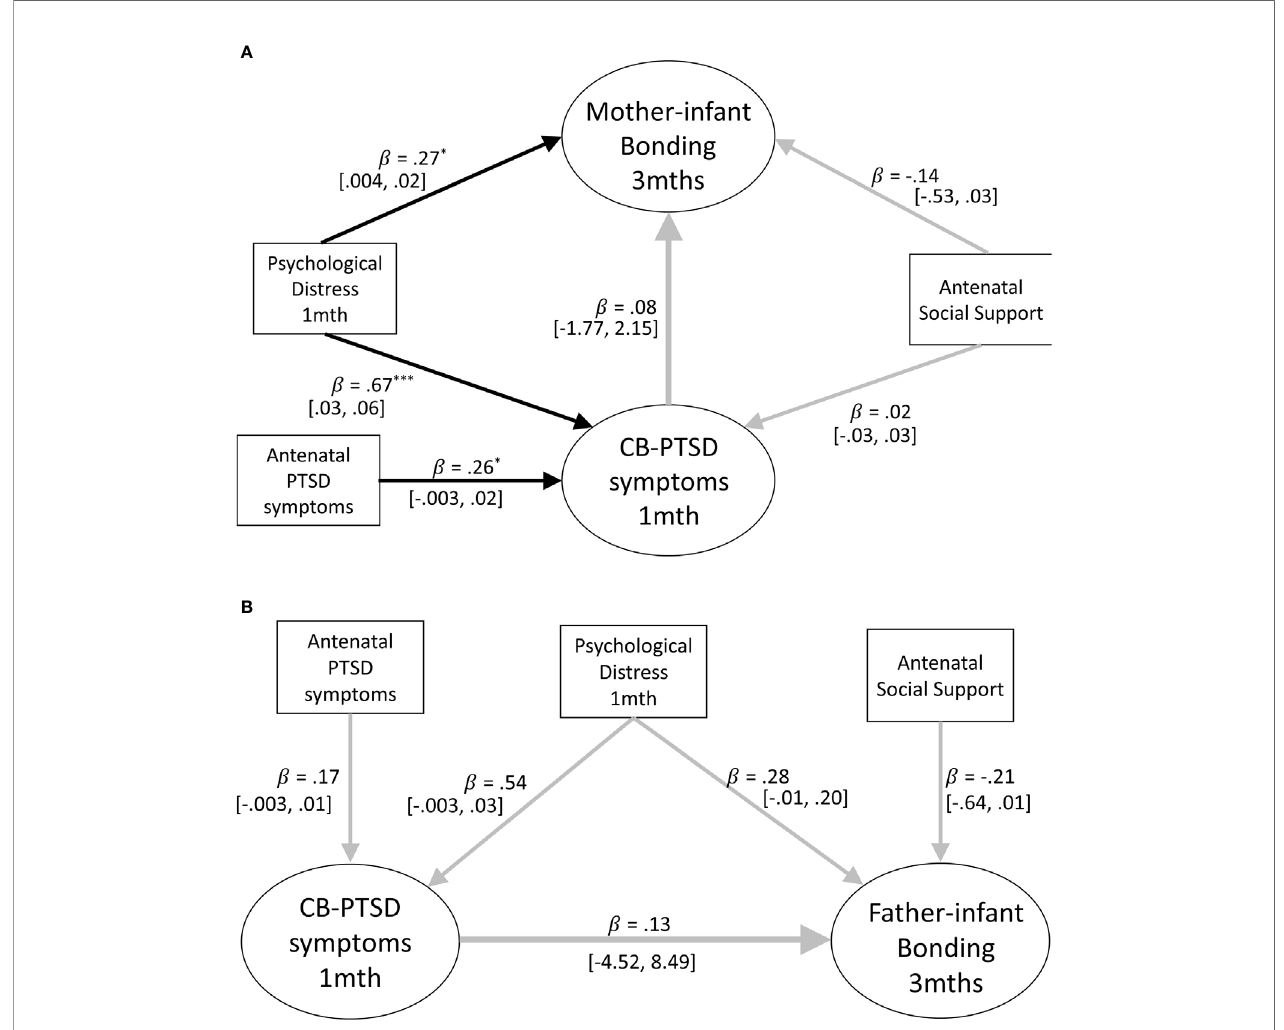
FIGURE 3 | (A) Path model of the prospective prediction of mother-infant bonding at 3 months by postpartum symptoms PTSD at 1 month, adjusting for concurrent psychological distress. Antenatal social support and PTSD symptoms are also included as covariates. Black lines indicate signi fi cant pathways, grey lines indicate non-signi fi cant pathways. Standardized coef fi cients and 95% con fi dence intervals are reported. *p < .05; **p < .01; ***p < .001. (B) Path model of the prospective prediction of father-infant bonding at three months by postpartum PTSD symptoms at one month adjusting for concurrent psychological distress. Antenatal social support and PTSD symptoms are also included as covariates. Black lines indicate signi fi cant pathways, grey lines indicate non-signi fi cant pathways. Standardized coef fi cients and 95% con fi dence intervals are reported. PTSD-CB, childbirth-related posttraumatic stress. *p < .05; **p < .01; ***p <